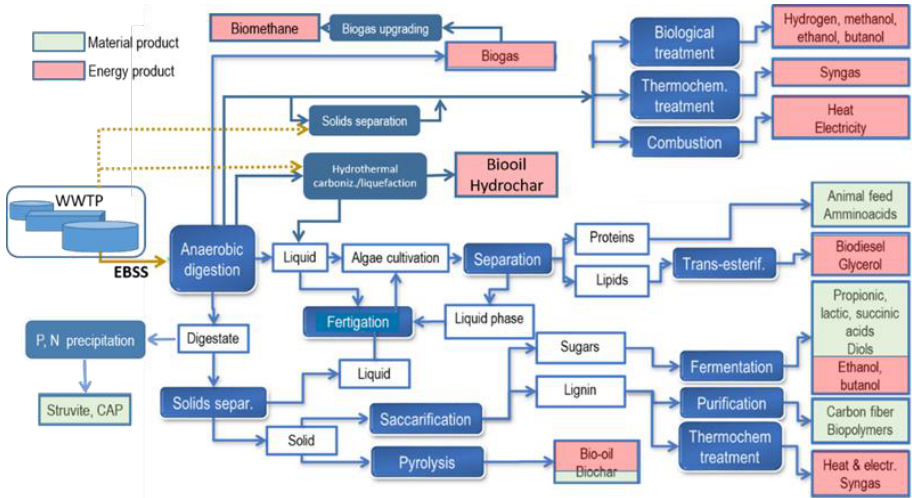
Figure 2. Possible biorefinery full-cycle implementation from EBSS feedstock.